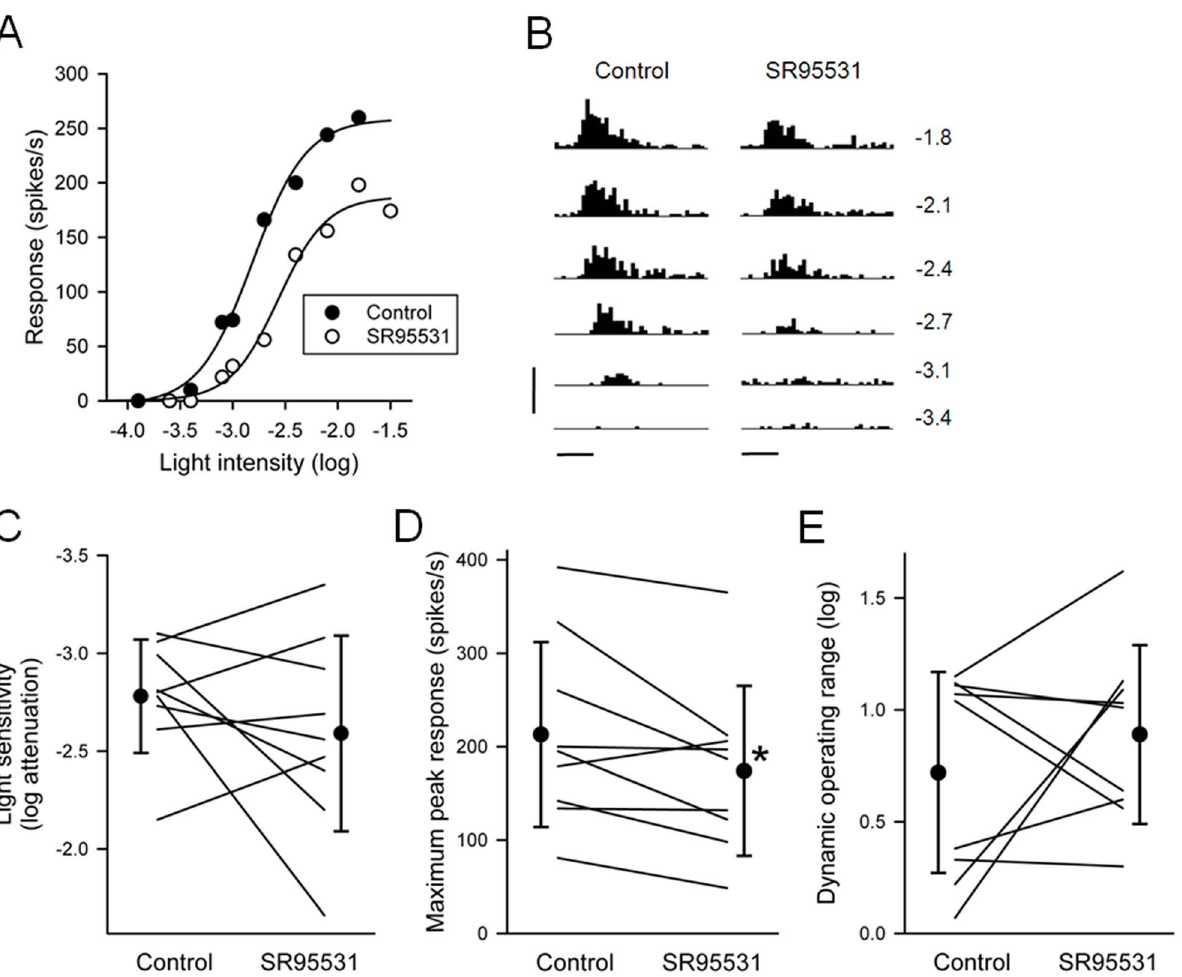
Figure 3. Effects of SR95531 on light responses of ON-center P23H rat RGCs. ( A ) Intensity-response curves from one RGC, taken before and during application of SR95531 (5 m M) to the bathing solution. The abscissa is labeled as log-unit attenuation in stimulus intensity from the maximum (8.5 6 10 17 photons/cm 2 /s). ( B ) Post-stimulus time histograms (10-ms bin width) of spike responses from the same RGC at six different light intensities. The values on the right are the number of log units of attenuation. Timing and duration (100 ms) of the light stimuli are indicated by the horizontal bars at the bottom. Vertical bar, 500 spikes/s. SR95531-induced change in ( C ) light sensitivity, ( D ) maximum peak response, and ( E ) dynamic operating range of ON-center P23H rat RGCs. Individual RGCs (n=9) are connected by lines. Each circle represents the mean ( 6 standard deviation) value. Asterisk indicates significantly different from control (P , 0.05).